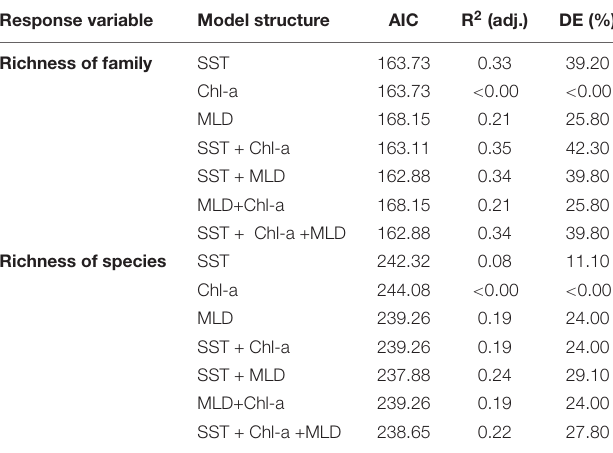
TABLE 2 | Generalized additive models (GAM s ) after fitting the relationship found in the 0–200 m layer, between family and species richness of calanoid copepods and oceanographic variables at Southeast Pacific, for the period 2002–2015 over an onshore-offshore (zonal) gradient. Response